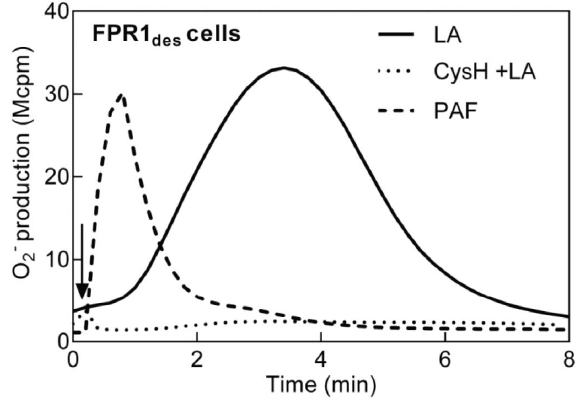
Figure 5. The cytoskeleton disrupting agent latruculin A induces reactivation of FPR1 des . Latrunculin A (100 ng/ml) was added to FPR1 des neutrophils (10 5 cells; desensitized with 0.1 nM fMIFL) in the absence (solid line) or presence (dotted line) of cyclosporin H (1 m M, FPR1 specific antagonist, added 1 min before latrunculin A) and the release of superoxide anions was determined. For comparison, a PAF-induced reactivation of FPR1 des neutrophils is included (dashed line). A representative experiment is shown, n . 5. Abscissa, time of study (min); Ordinate, superoxide production (counts per minute 6 10 6 ;